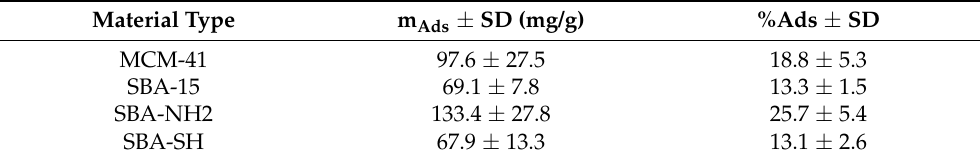
Table 1. Mean adsorption efficiency together with the amount of GA adsorbed per 1 g of